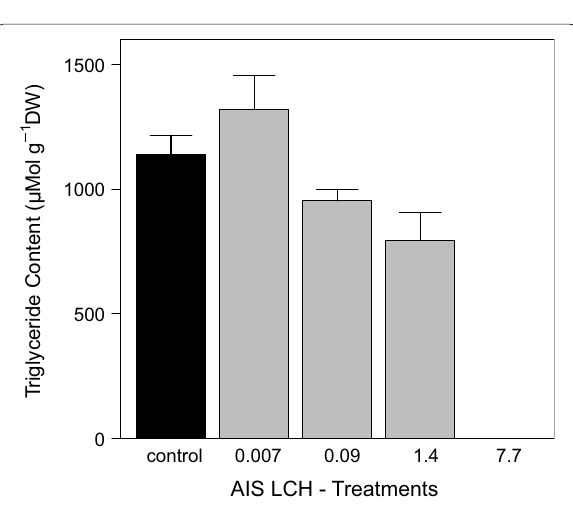
Fig. 11 Grazer triglyceride contents at the end of the LCH AIS experiment in the different treatments [mean triglyceride levels were determined in the highest LCH treatment, due to total mortality. All LCH treatments in µg g − 1